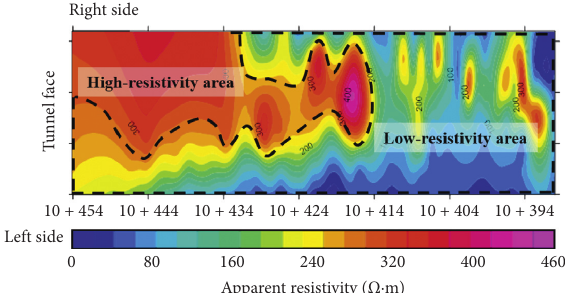
Figure 7: Apparent resistivity contour image from TEM.